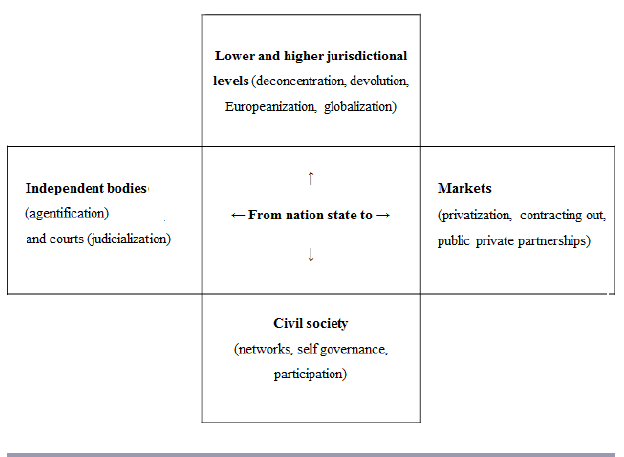
Fig. 1 . Shifts in governance since the